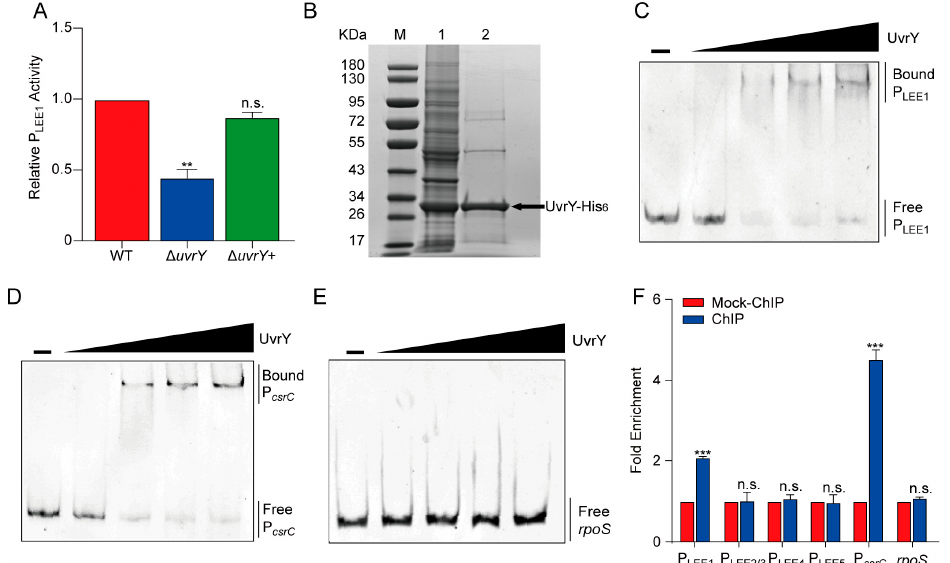
Figure 4. UvrY directly binds to the promoter of the ler . ( A ) A bar plot showing the LEE1- lux activity in WT, Δ uvrY , and Δ uvrY + strains, respectively. LEE1- lux activity values in WT were normalized to 1. ( B ) SDS-PAGE photograph of the purified UvrY-His 6 . Lane M: protein marker; Lane 1: total protein; Lane 2: purified UvrY-His 6 protein. ( C – E ) Chemiluminescence photographs showing the EMSA result for the binding affinity of protein UvrY-His 6 with ( C ) the ler (LEE1) promoter; P LEE1 , ( D ) csrC promoter; P csrC , and ( E ) rpoS coding region. ( F ) A bar plot showing the relative fold enrichment of the promoter fragments of LEE1, LEE2/3, LEE4, and LEE5 in ChIP samples compared with mock-ChIP samples, measured using q-PCR. P csrC and rpoS were calculated as a positive or negative control, respectively. Significance was determined using two-tailed unpaired Student’s t -test ( A , F ). ** represents p ≤ 0.01; *** represents p ≤ 0.001; n.s. represents no significant